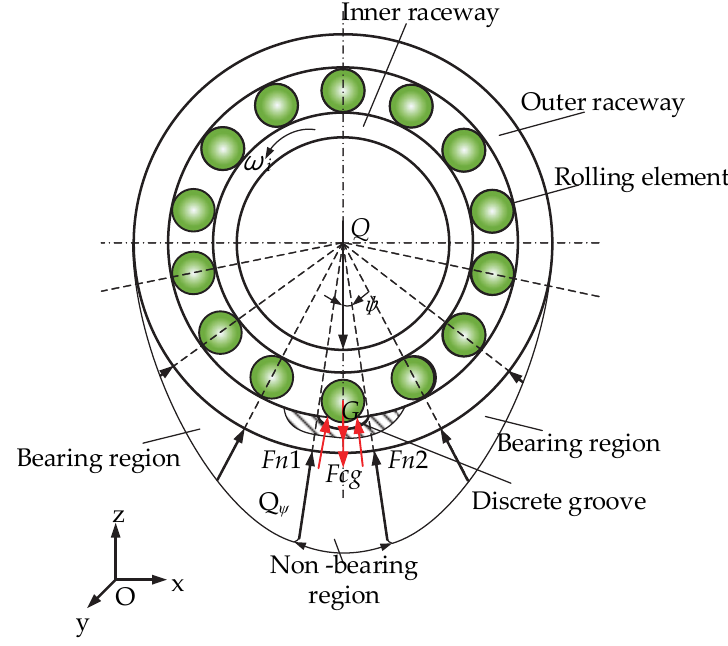
Figure 3. Force analysis of ball bearings without a cage. As shown in Figure 3, for the radial load Q , the upper half of the rolling element due to the inner ring is oriented downward and is not bearing, but the lower half of the rolling element will bear the load. Thus, in the upper half of the rolling element in the non-bearing region, the total load between the rolling elements and the outer raceway is expressed by the sum of gravity and centrifugal force. Due to the rolling element in the groove when the mass of the touch down and the inner raceway do not contact, the rolling element does not carry, as it is only affected by gravity G and centrifugal force F cg ; at this time, the total load between the rolling element and the touch groove is only the rolling element’s own gravity and centrifugal